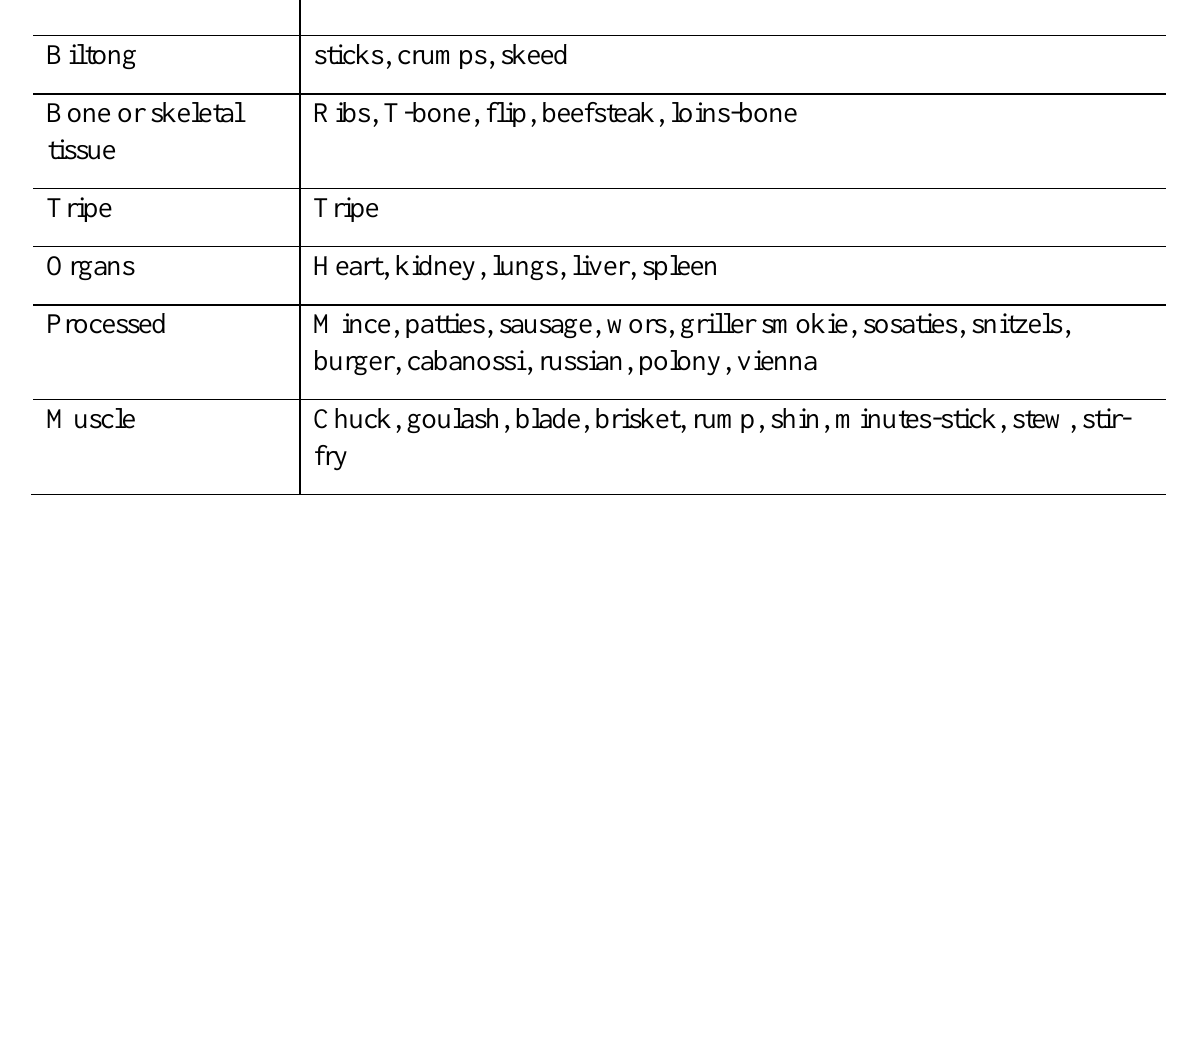
TABLE S3 : Meat products according to sample categories.